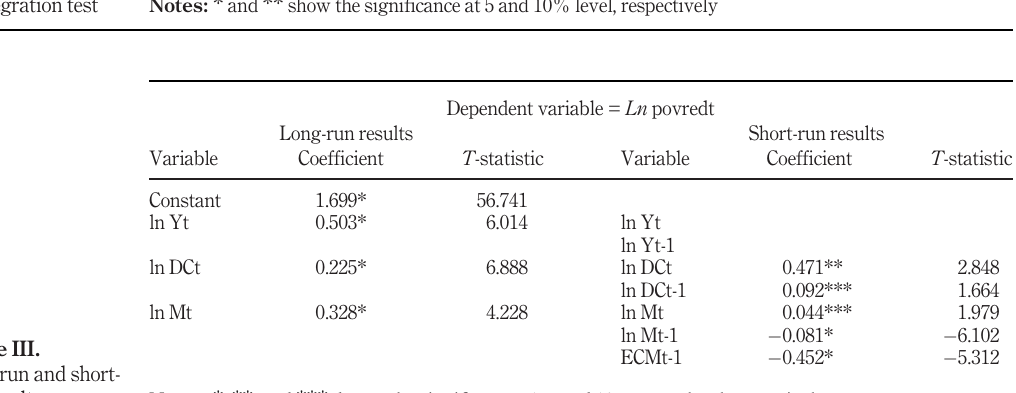
Table II. Results of ARDL cointegration test